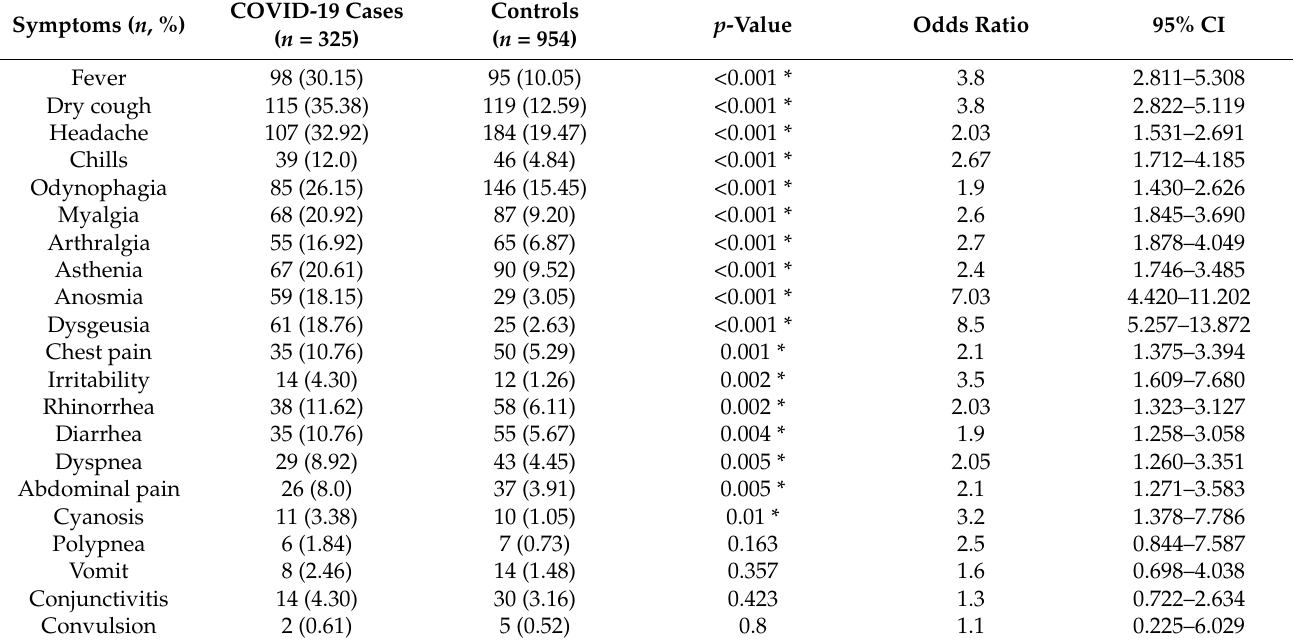
Data are represented as frequency and percentages. p -values were obtained by the comparison of symptoms between patients with SARS-CoV-2 RT-PCR (+) and RT-PCR (-). * Significant p -values of <0.05. The odds ratio is the comparison between the proportions of cases positive and negative for SARS-CoV-2 by